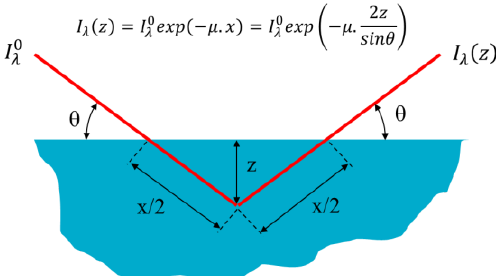
Figure 2. Absorption of the radiation in a Bragg – Brentano configuration.